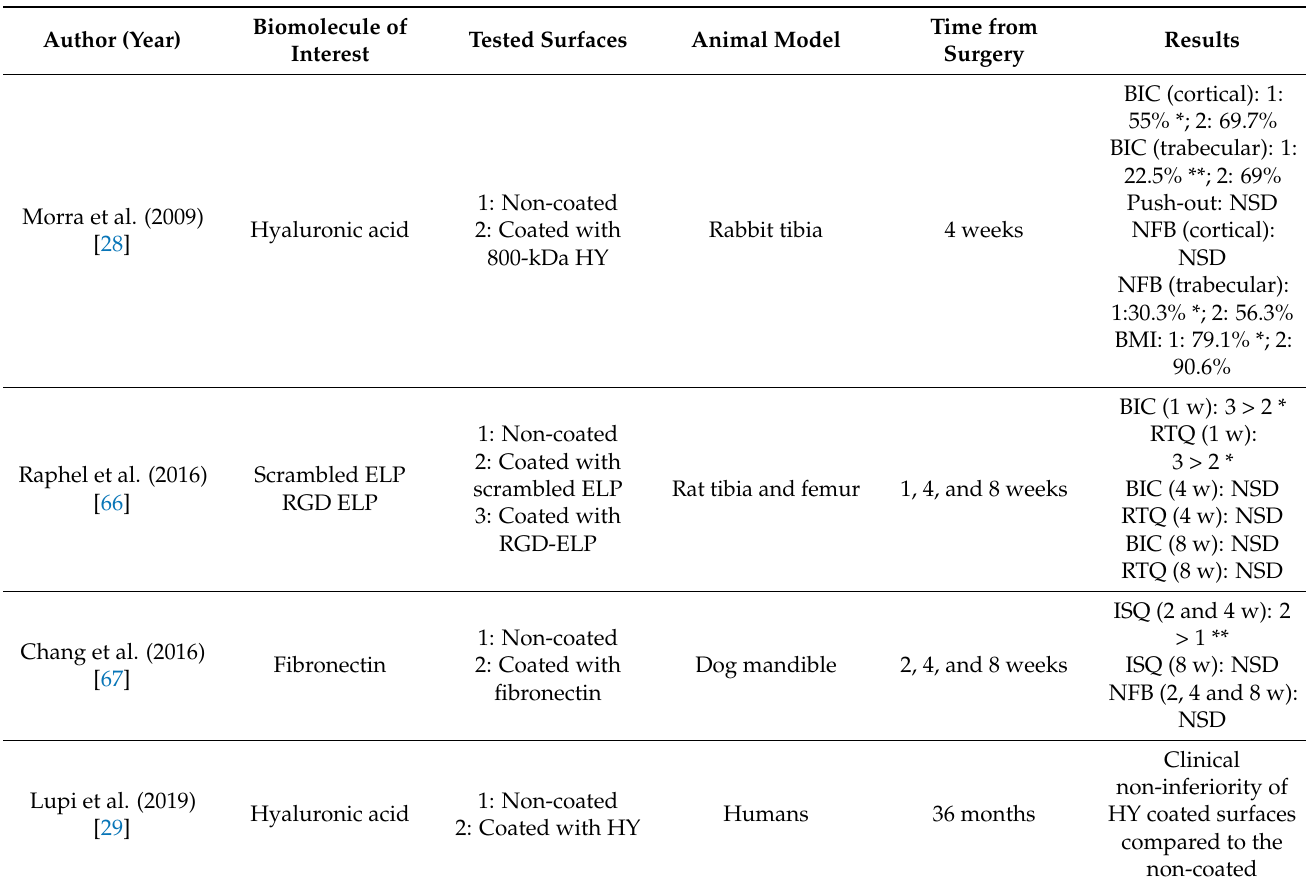
Table 7. Other ECM components investigated: results from the considered